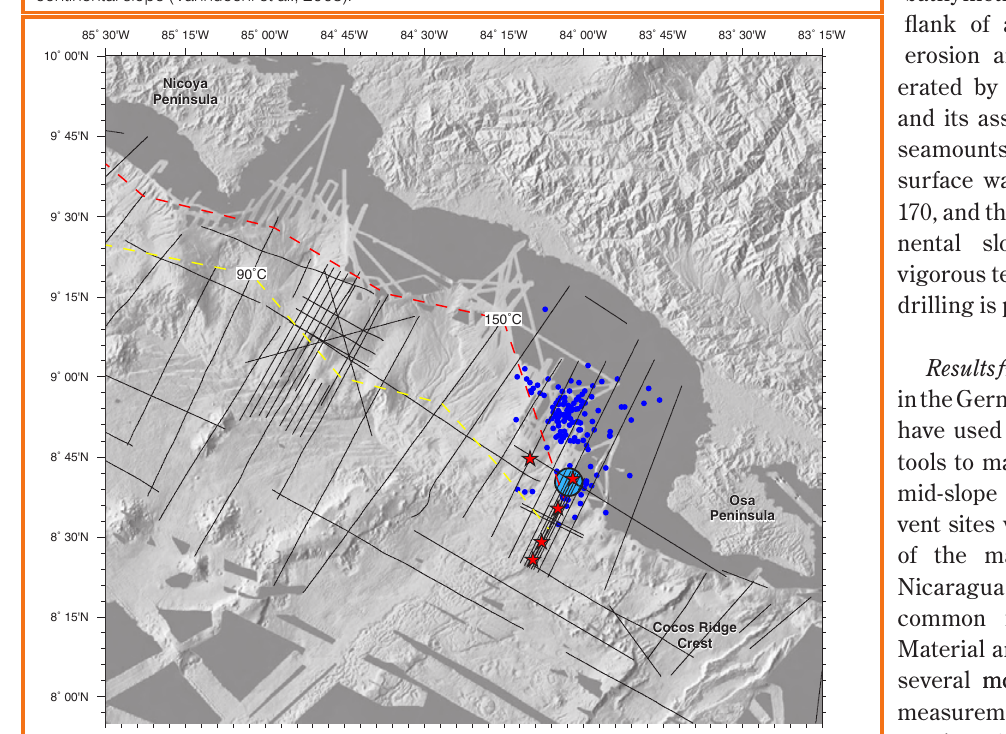
Figure 2. Multibeam bathymetry and topography of the Costa Rica margin between Nicoya and Osa Peninsula. Dashed lines delineate the 90°C and 150°C temperature isotherms along the plate boundary. Large blue circle marks nucleation area of the 2002 Mw6.4 earthquake, and small blue circles are aftershocks occurring during 6 days after the main shock (I. Arroyo, unpublished). Drill site in the upper slope is located on the nucleation area of the 2002 Mw6.4 earthquake (see Fig. 4). Black lines indicate tracks of multichannel seismic reflections profiles collected during SONNE 81 and BGR99 cruises.